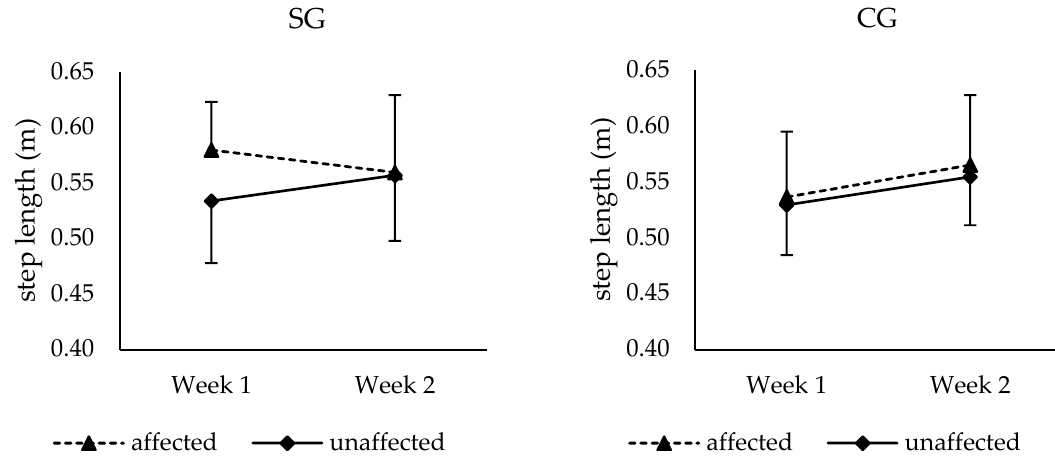
Figure 3. Step length of the affected and unaffected leg for SG ( n = 10) (left) in week 1 and week 2, step length of the affected and unaffected leg for CG ( n = 10) (right) in week 1 and week 2. Values are means ± standard deviation.